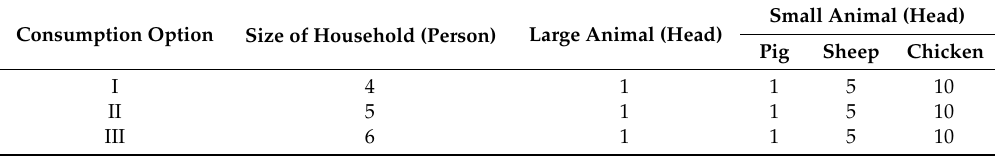
Table 1. Types of water consumption use in the northern region of China.